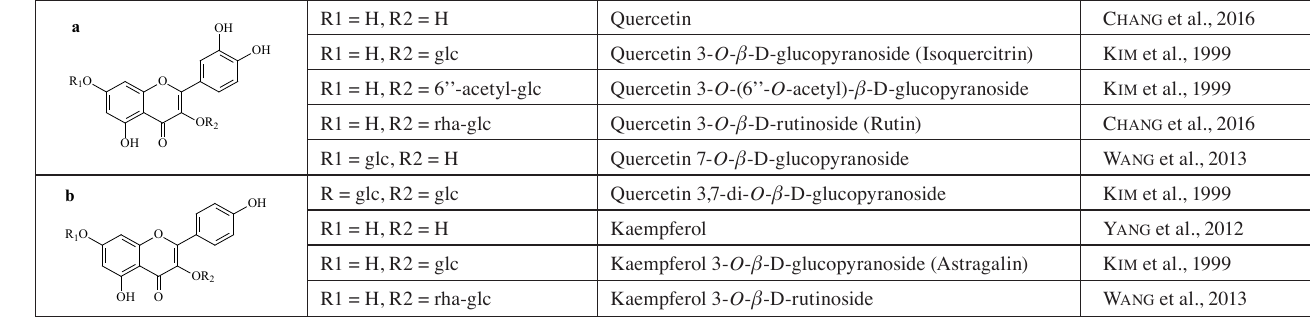
Tab. 1: Selected flavonoids with quercetin and kaempferol aglycones isolated from mulberry